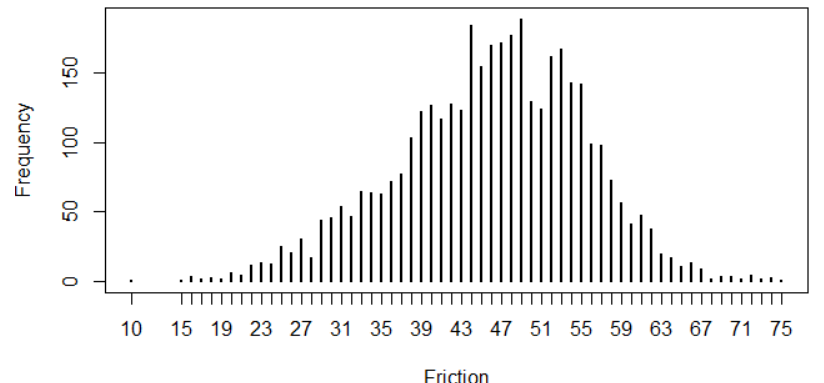
Figure 2. Frequency of various friction numbers.